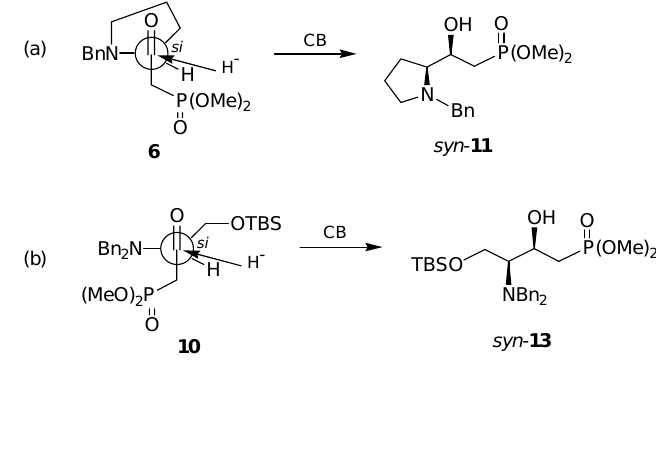
Figure 2. Reduction of the β -ketophosphonates 6 and 10 by non-chelation